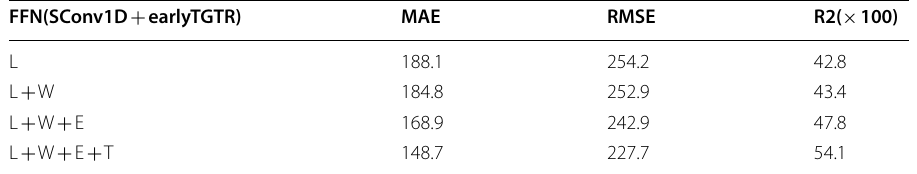
Table 5 TFFN (SConv1D earlyTGT) performance on the test set under different information + sources FFN(SConv1D earlyTGTR) +